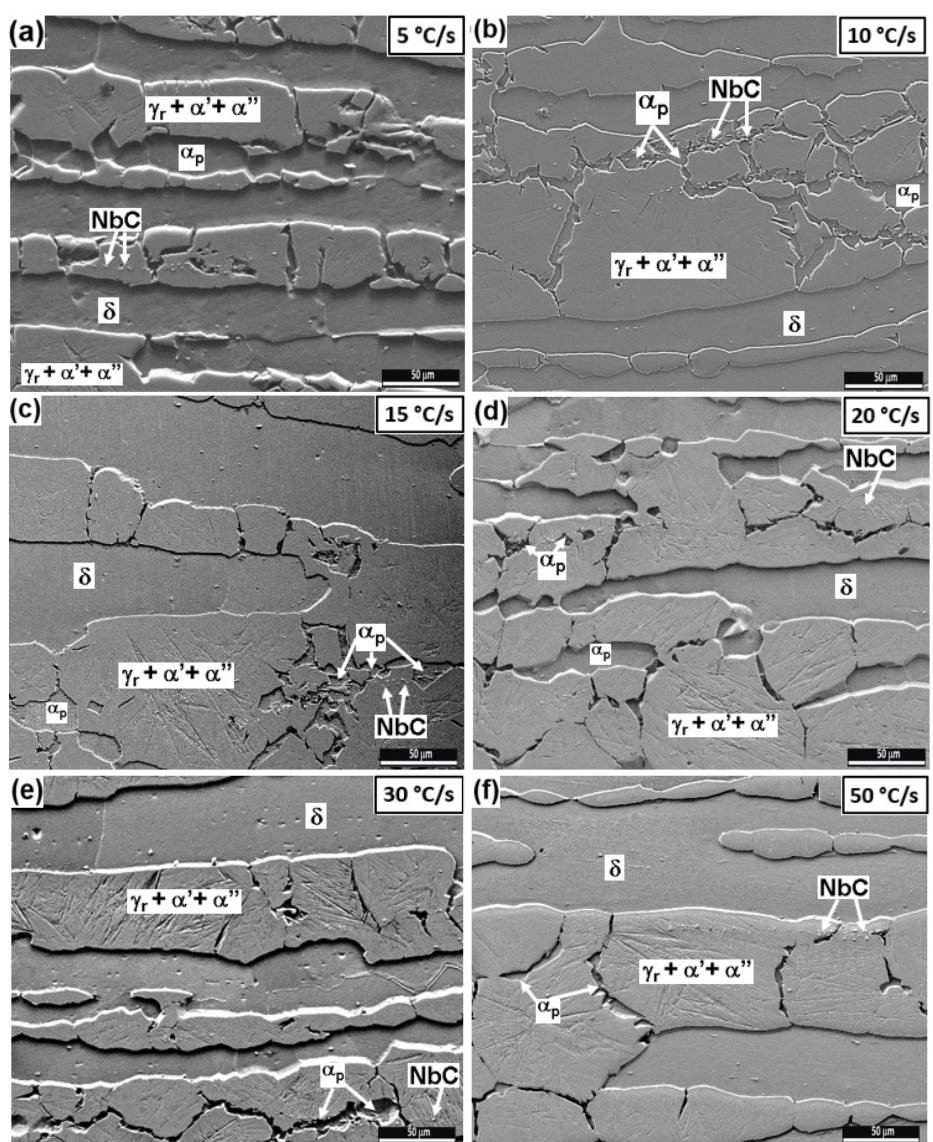
Figure 7. Micrographs (SEM/SE) of the samples obtained after dilatometry tests at cooling rates of: ( a ) 5 °C/s; ( b ) 10 °C/s; ( c ) 15 °C/s; ( d ) 20 °C/s; ( e ) 30 °C/s; ( f ) 50 °C/s ( γ r = retained austenite; δ = δ -ferrite; α = α -ferrite; α p = proeutectoid α -ferrite; α′ = BCC martensite; α″ = BCT martensite; NbC = niobium